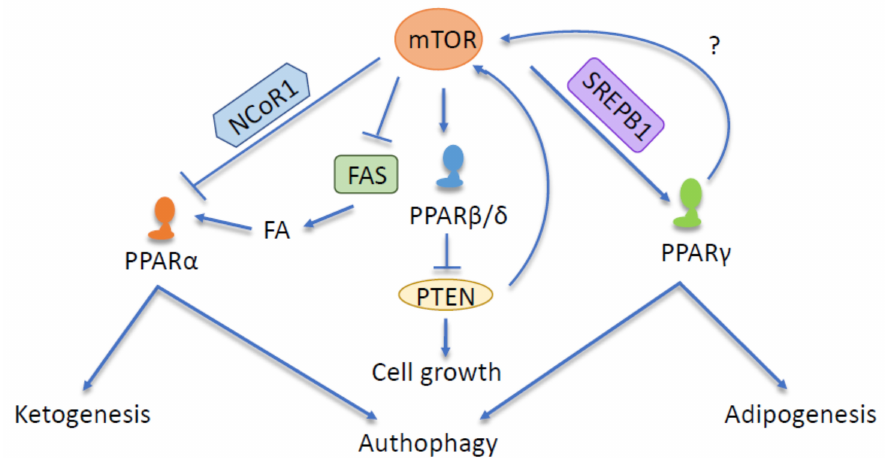
Figure 3. Interactions between PPARs and mTOR. mTOR interacts with all PPARs, resulting in the modulation of ketogenesis, autophagy, and